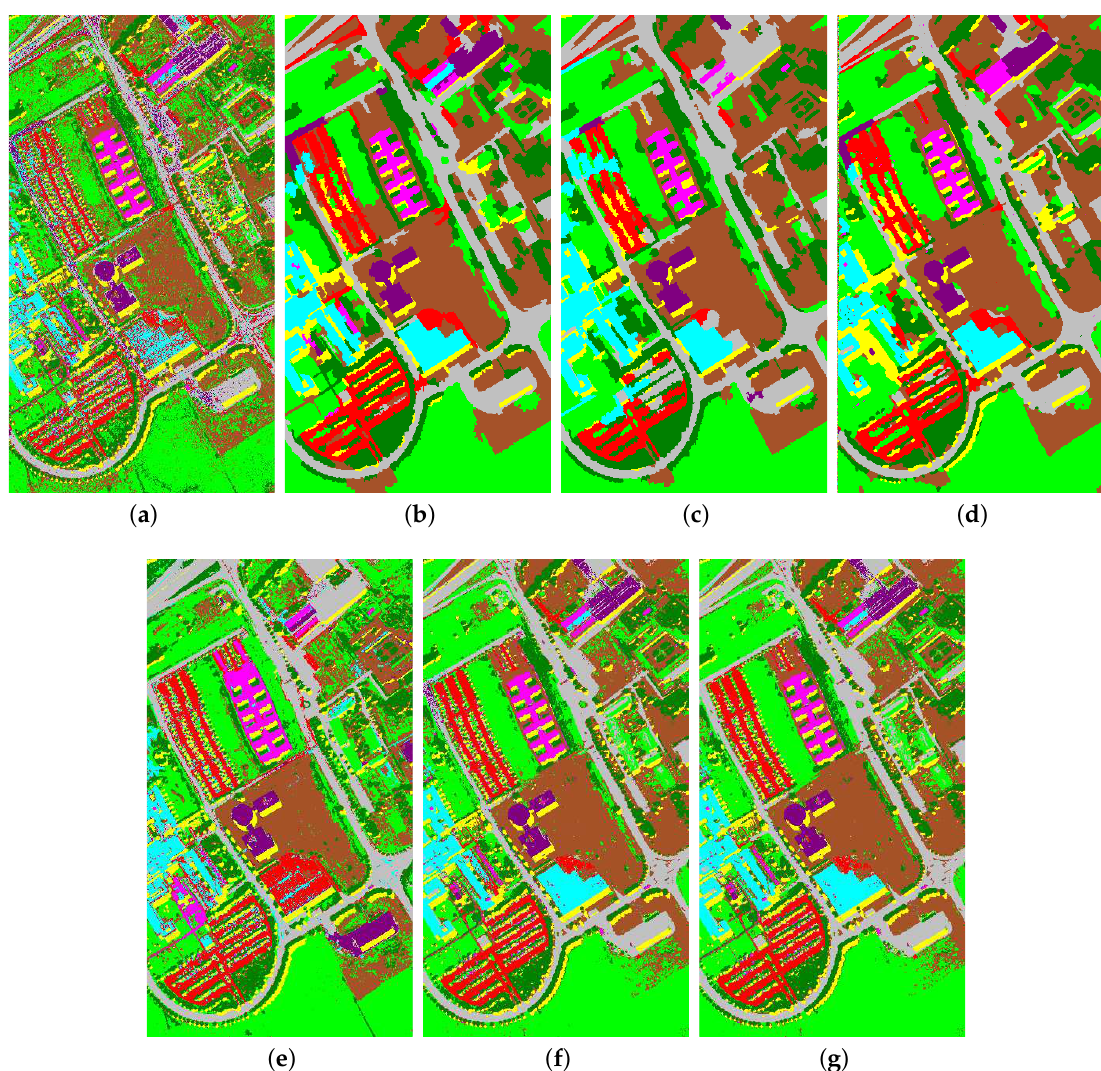
Figure 6. Classification maps and overall classification accuracies (in parentheses) obtained for the ROSIS University of Pavia dataset using different classification methods. ( a ) KSRC (83.44), ( b ) MV (93.71), ( c ) KJSRC (94.55), ( d ) CRF (95.56), ( e ) CKEMAP (96.67), ( f ) SSG (97.57), ( g ) SSGL